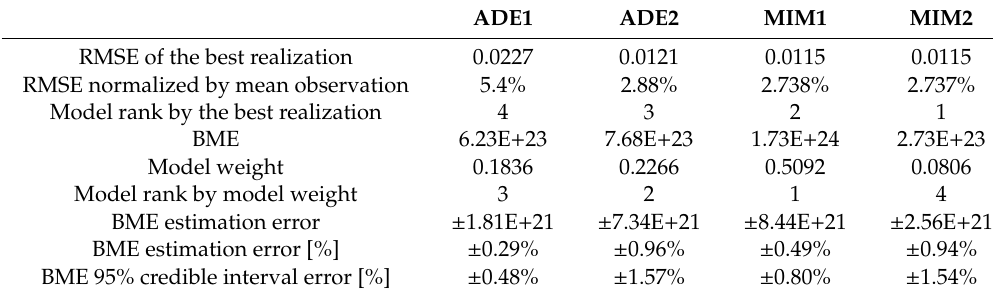
Table 3. Metrics and model ranking of the candidate models based on the best realization (i.e., RMSE) and based on the average model fit of all the parameter values that the model can take (i.e., BME and model weight). The results are based on the implementation of AM. ADE1 ADE2 MIM1 MIM2